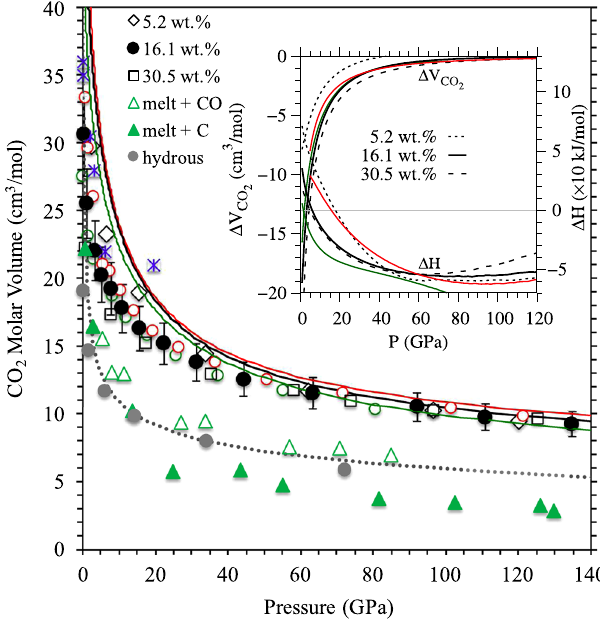
Figure 5. Mixing properties of melt-CO 2 solution. The calculated partial molar volume ( V dioxide component in MgSiO 3 liquid at 3000 K (green circles), 4000 K (black circles), and 5000 K (red circles) for 16.1 wt.% CO 2 and at 4000 K also for 5.2 and 30.5 wt.%. The partial molar volume is defined